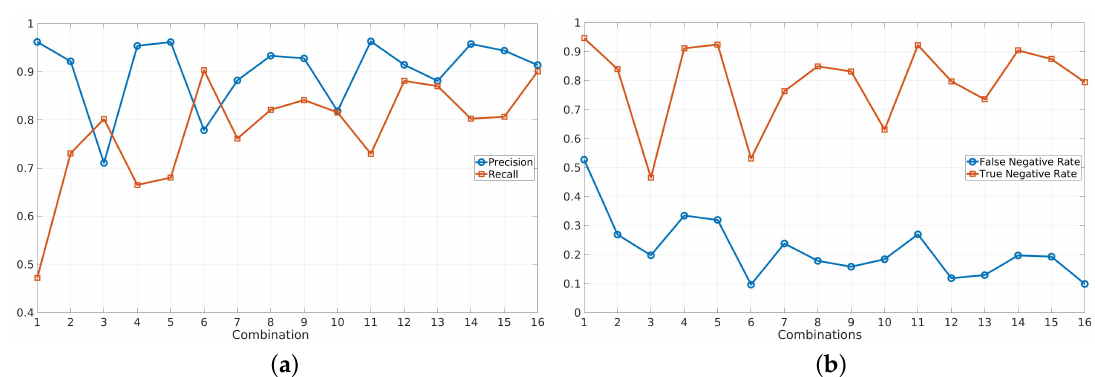
Figure 3. ( a ) Precision and Recall, ( b ) True Negative Rate (TNR) and False Negative Rate